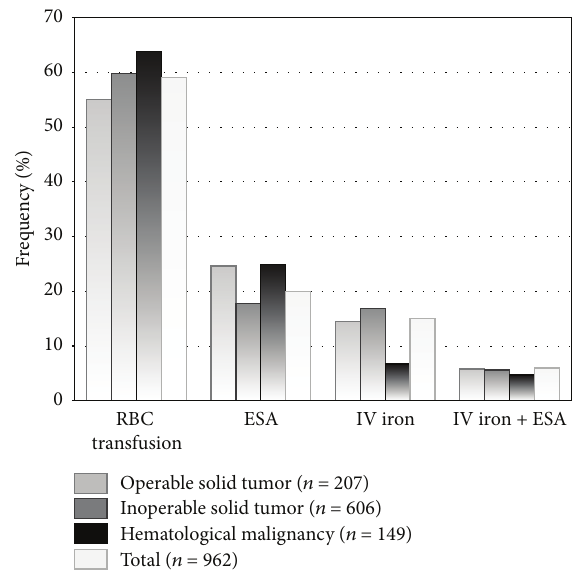
Figure 2: Frequency of antianemic day 1 treatments by type of